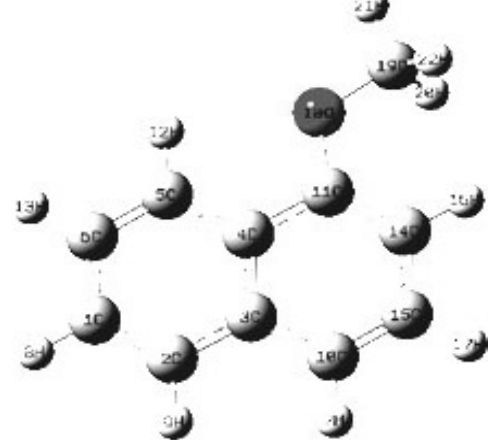
Figure 1. Molecular structure of